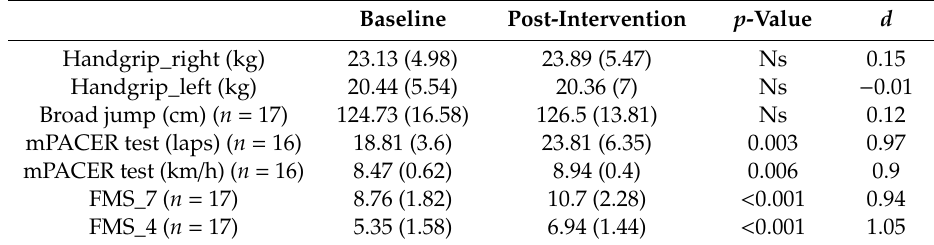
Table 4. Changes in physical function expressed as mean